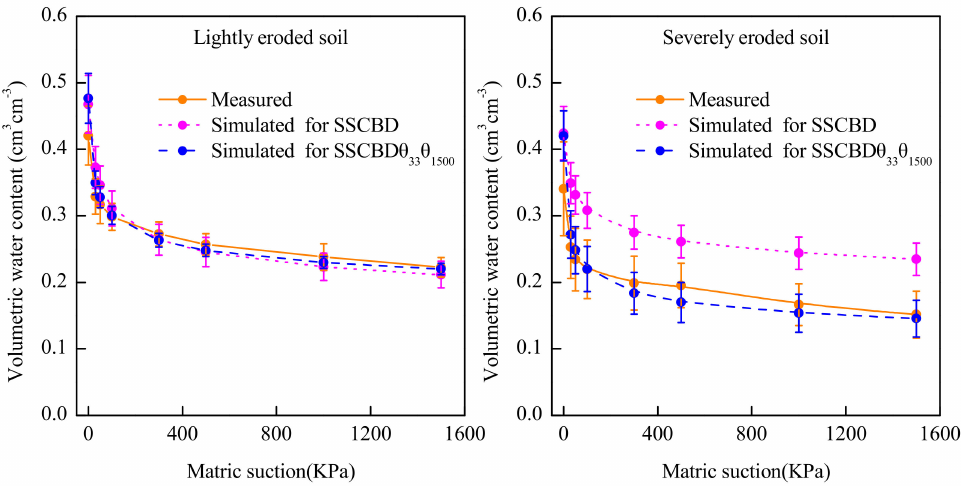
Figure 6. Comparison of the measured and simulated soil water contents after correction, using the input of SSCBD and SSCBD θ 33 θ 1500 , respectively, for the lightly and severely eroded soils. For lightly eroded soil, the water contents of fitting results of the model in low suctions were higher than those measured after correction. Compared using SSCBD θ 33 θ 1500 , the e ff ects of fitting results when using SSCBD in saturated water contents were better. For severely eroded soil, the e ff ects of fitting results when using SSCBD θ 33 θ 1500 were improved after correction, while there were no significant improvements when using input sets of SSCBD. The water contents of fitting results of the model in low suctions were higher than those measured after correction using SSCBD θ 33 θ 1500 , while the fitting results when using SSCBD were all higher than